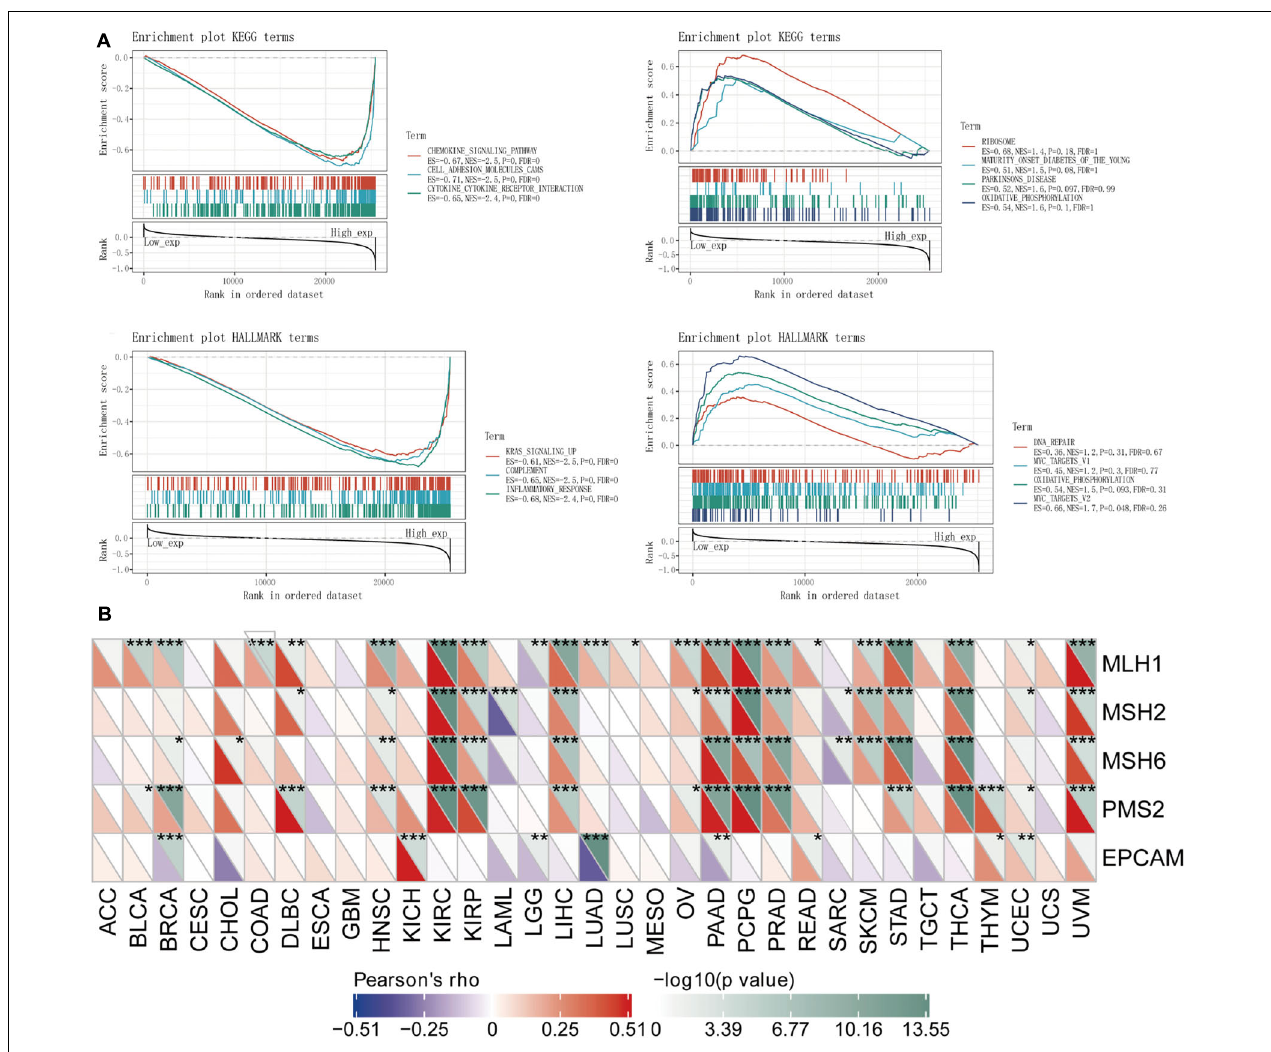
FIGURE 6 | Analysis of the TLR4 gene enrichment and DNA repair genes. (A) KEGG analysis displayed that TLR4 was highly expressed in chemokine signaling pathway ( p = 0), cell adhesion molecule ( p = 0), and interaction of cytokine receptor ( p = 0). HALLMARK analysis showed that TLR4 is lowly expressed in MYC_TARGETS_V2 ( p = 0.048) and highly expressed in KRAS signaling pathway ( p = 0) and inflammatory response ( p = 0) pathway. (B) The TLR4 gene expression was highly linked to DNA repair genes MLH1, MSH2, MSH6, and PMS2 in KIRC and STAD and MLH1, MSH2, and MSH6 in SKCM (** p < 0.001); mildly correlated with MLH1, MSH2, and PMS2 in UCEC (* p < 0.001) 05); and showed a moderate correlation with EPCAM (** p < 0.01). A p -value < 0.05 was considered statistically